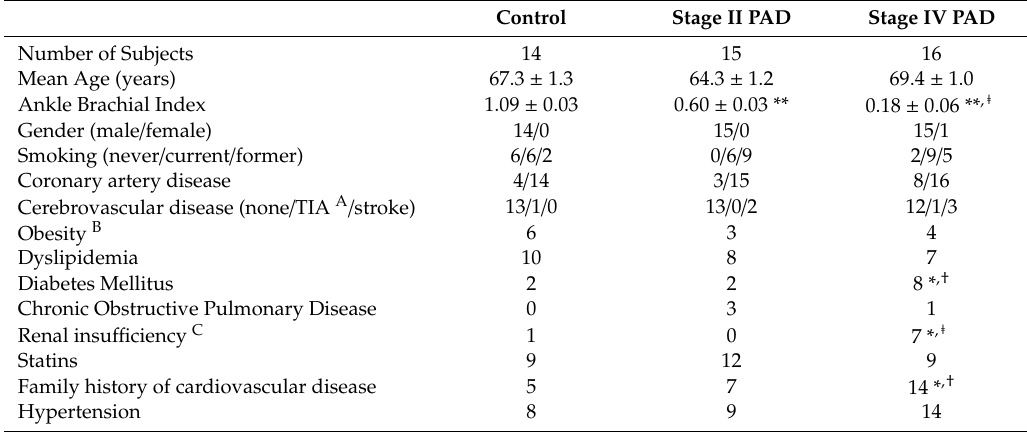
Table 1. Patient